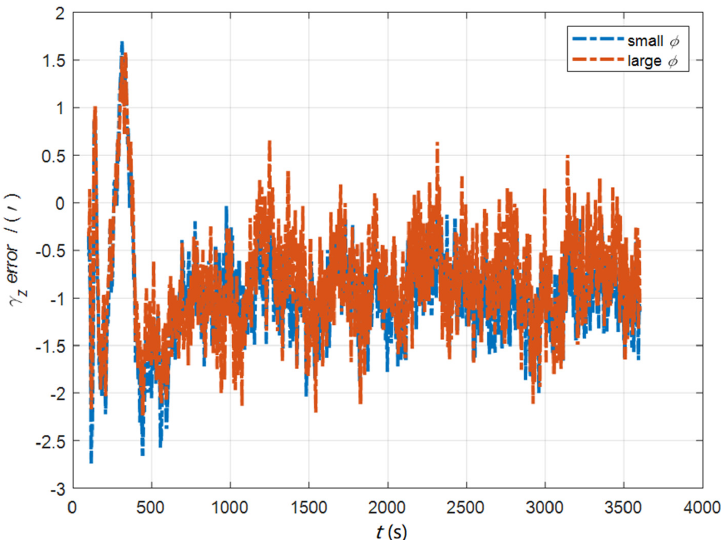
Figure 30. The error curves of γ y in the case of large and small initial misalignment angles.